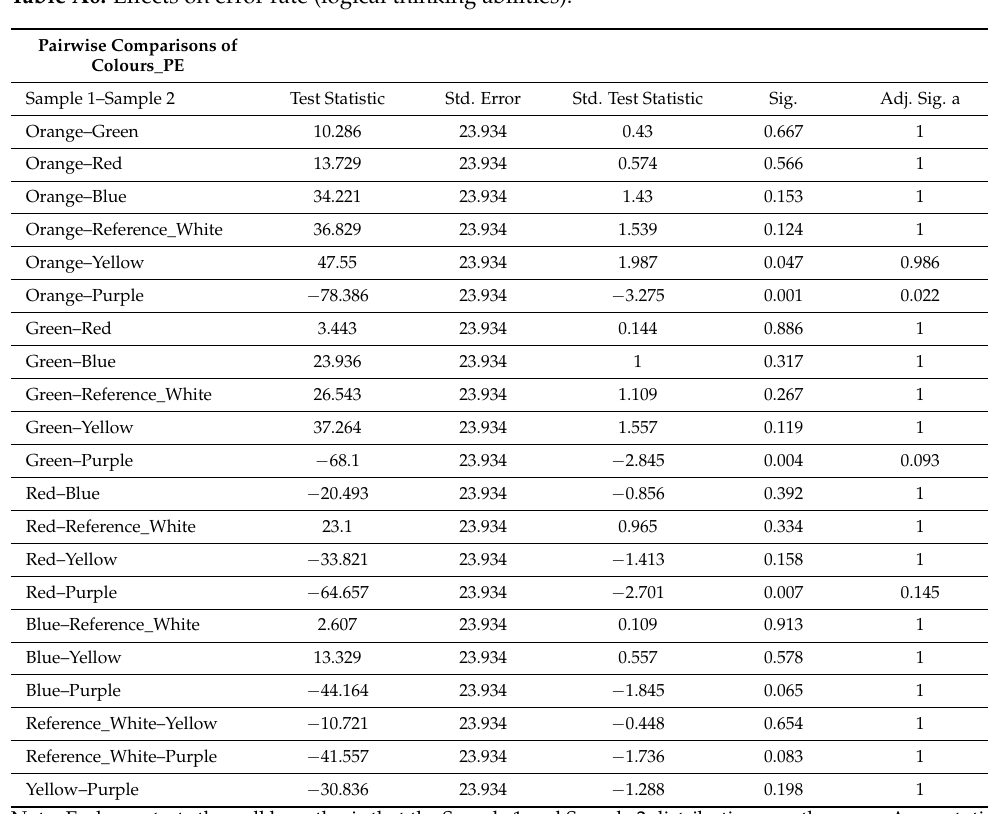
Table A6. Effects on error rate (logical thinking